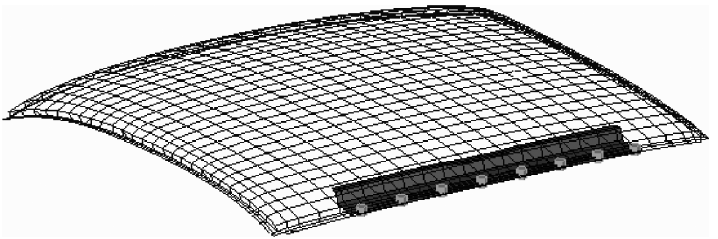
Fig. 5. Successful connection of car roof and crossbeam.